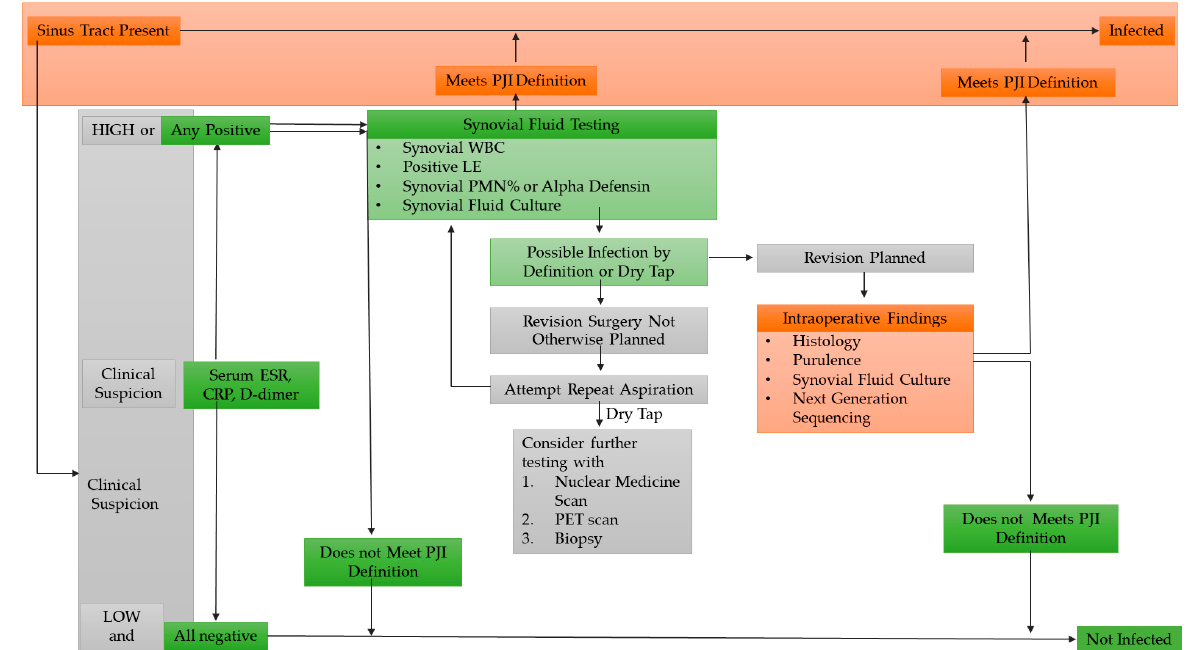
Figure 1. Criteria and strategies used in PJI (periprosthetic joint infection) diagnosis. Legend: ESR, erythrocyte sedimentation rate; CRP, C-reactive protein; WBC, white blood cells; LE, leukocyte esterase; PMN, polymorphonuclear neutrophil (modified from Alvand et al., 2020 [15] with permission).